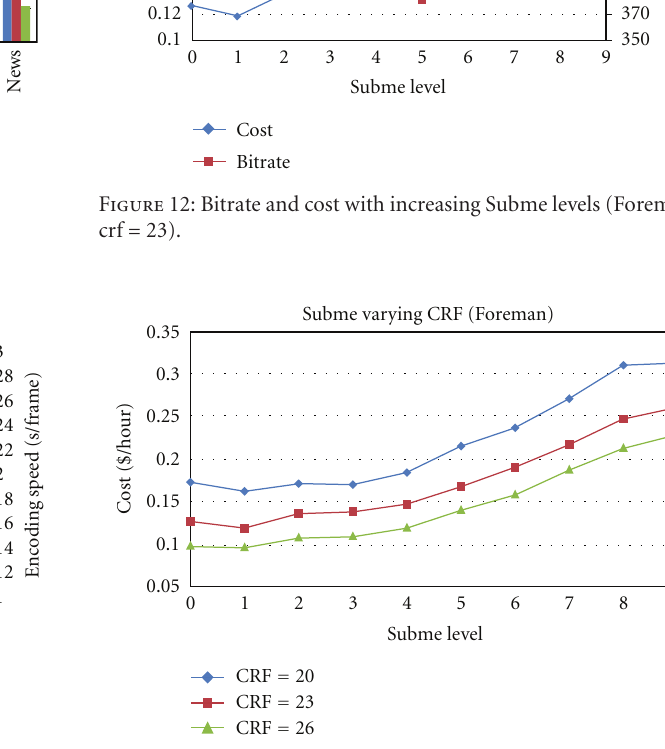
Figure 11: Encoding cost and rate with increasing Subme levels (Foreman, crf = 23).